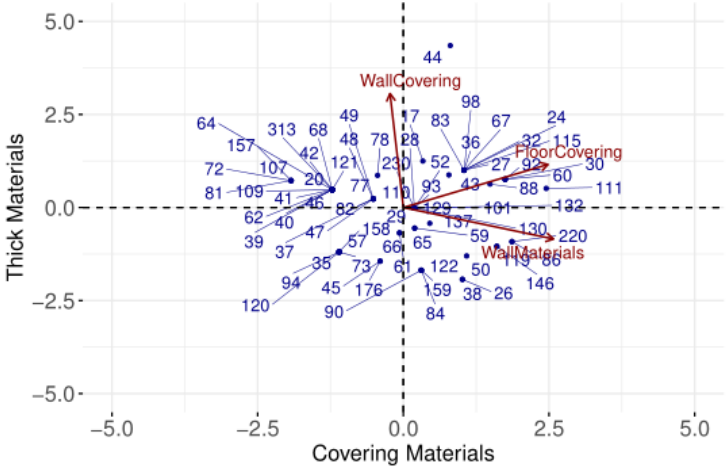
Figure 12. Biplot obtained from the fourth analysis (see Table 1).